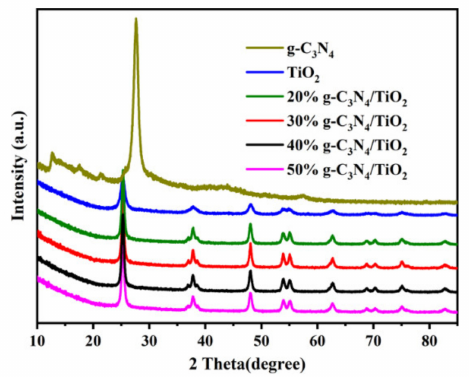
Figure 3. The XRD patterns of TiO 2 , g-C 3 N 4 , and g-C 3 N 4 /TiO 2 samples with different mass